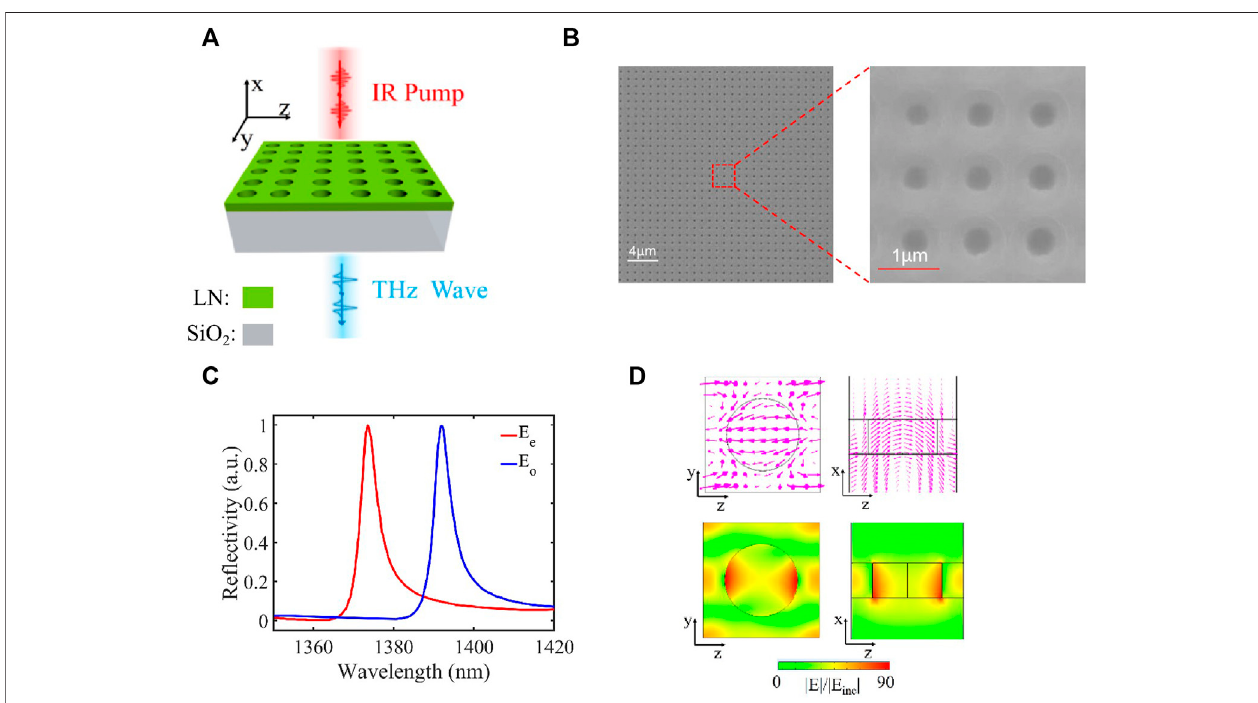
FIGURE 1 | Schematic representation of the LiNbO 3 nonlinear metasurface. (A) Metasurfaces are fabricated on an x-cut LNOI fi lm residing on SiO 2 . The x - and z -axis of the experimental coordinate system are along the x -axis of the LiNbO 3 principal crystallographic coordinate and the polarization of pump pulses, respectively. The collimated femtosecond pulses excite the metasurface with the normal incidence, and the transmitted THz waves are recorded. (B) Scanning electron microscopy images of the LiNbO 3 metasurface with a period of 950 nm and the magni fi ed image of pores with a diameter of 550 nm. (C) Simulated re fl ection spectrum of the LiNbO 3 metasurface rotating the optical axis of LiNbO 3 along the z -axis (extraordinary electric fi eld E e , red) and y -axis (ordinary electric fi eld E o , blue). The resonant wavelengthsare1,375and1,395 nmwhentheopticalaxisisparallelandperpendiculartothepolarizationofthepumppulses,respectively. (D) Distributionoftheelectric fi eld in the y-z (left) and x-z (right) sections of a LiNbO fi gures indicate the direction of the electric fi eld. The bottom 3 nanoresonator, respectively. The arrows in the top fi gures show the amplitude pro fi les of the electric fi eld.